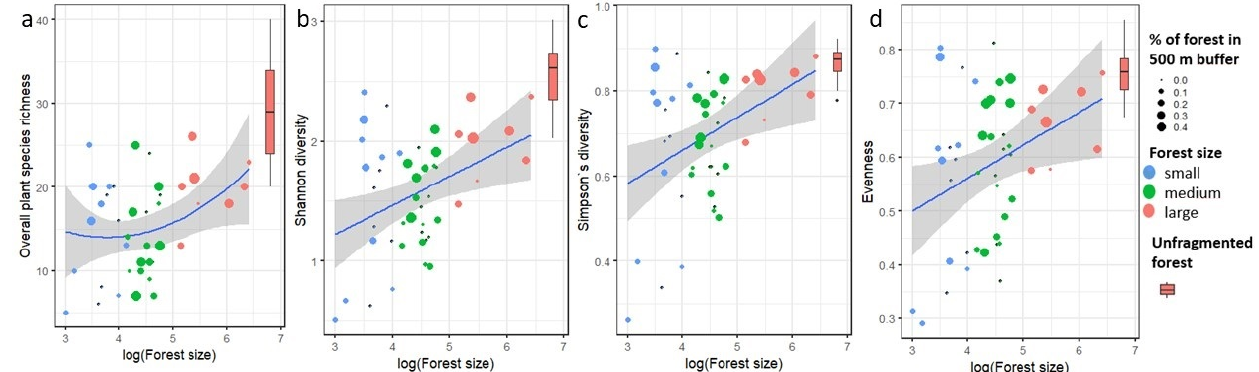
Figure 4. Effect of forest fragment size on plant diversity evaluated by ( a ) plant richness, ( b ) Shannon diversity, ( c ) Simpson’s diversity, and ( d ) evenness. The color and size of the dots correspond to the forest fragment size group and % of forest cover in 500 m buffer. Control unfragmented forest Murska šuma is shown by a bar (minimum, 1st quartile, median, 3rd quartile, maximum). Species richness increased by 32–54%, Shannon diversity increased by 22–32%, Simp- son’s index by 8–25%, and evenness by 12–28% if we compare different-sized forest